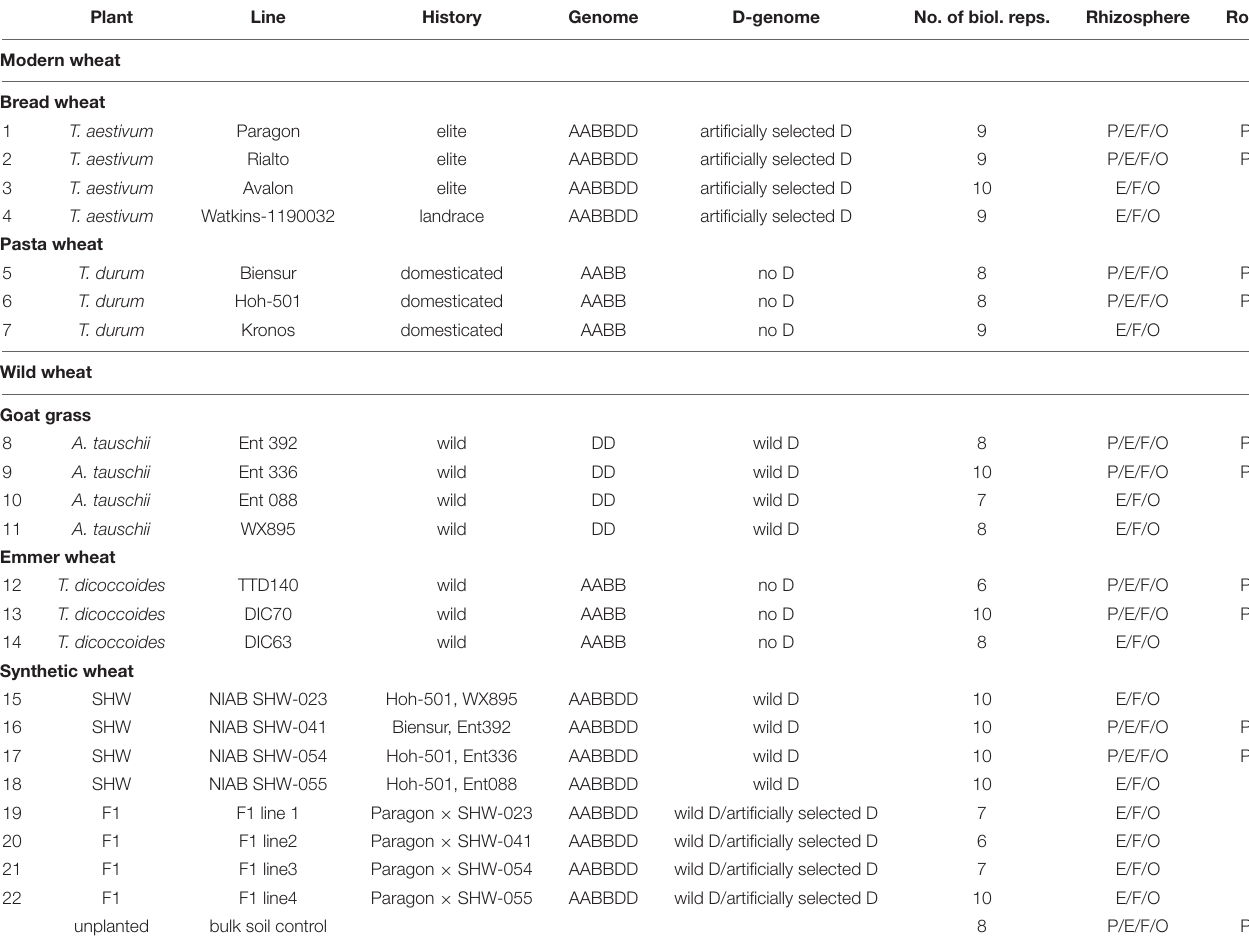
TABLE 1 | Wheat species and analysis performed. Plant Line History Genome D-genome No. of biol. reps. Rhizosphere